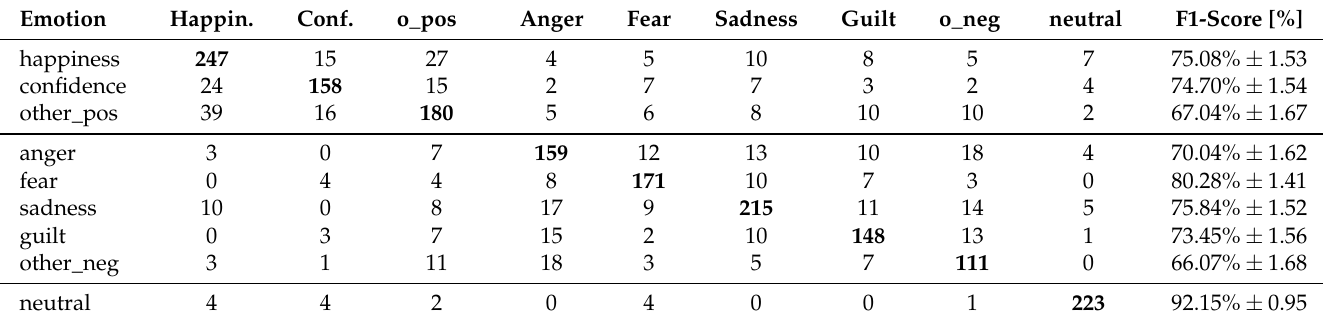
Table 4. Confusion matrix for emotion classification in Polish with BERT model for test subset. Confidence intervals given for confidence level 90%. Emotion